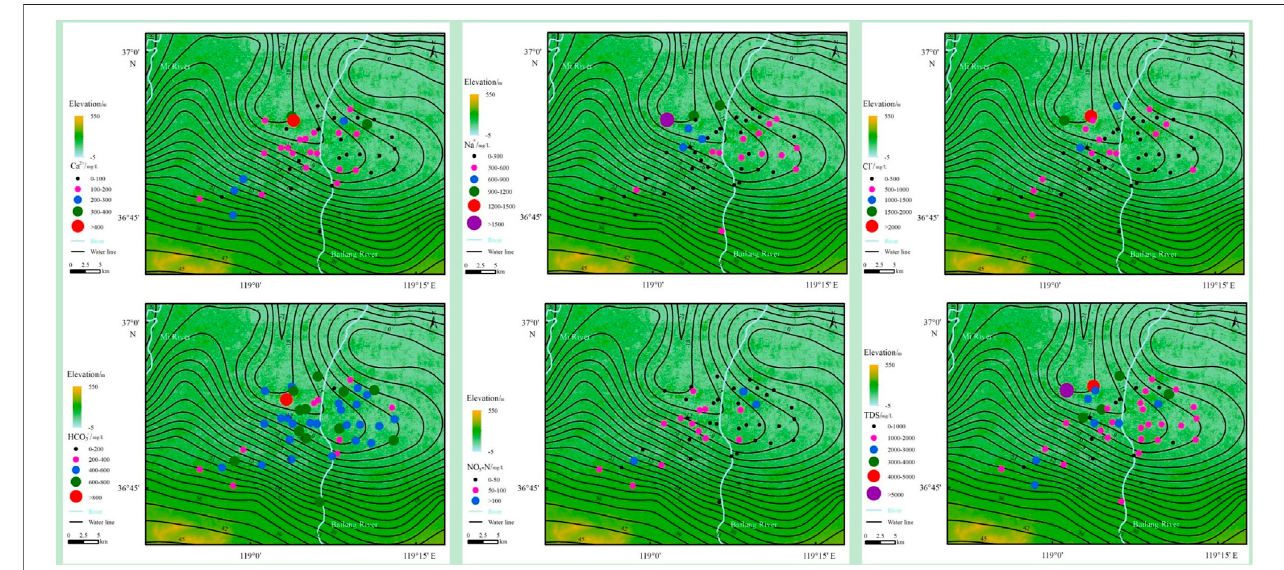
FIGURE 3 | The Piper program of groundwater samples in study area.